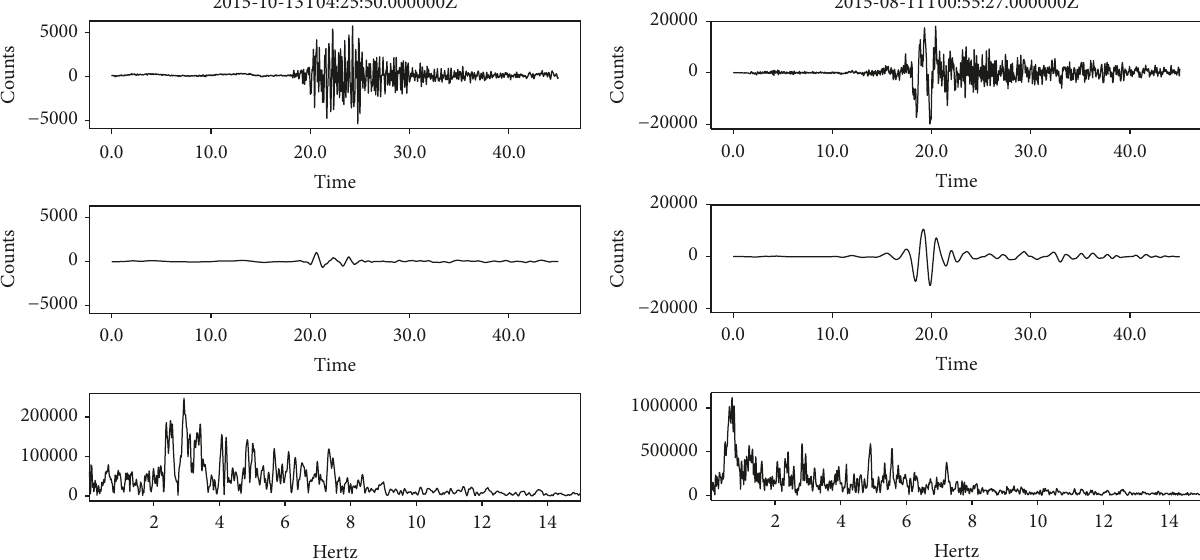
Figure 3: Typical events (top) from family 1, filtered signals between 0.3 and 1 Hz (mid), and spectral density vectors (bottom). The signals frequency content is varied, yet low frequency content is important as depicted above. Horizontal axis is time and vertical axis is counts.